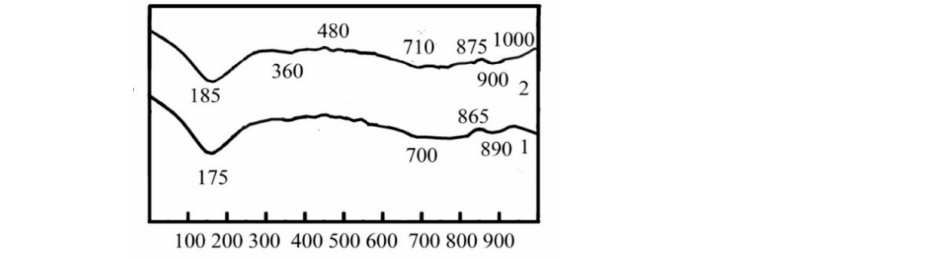
Figure 7. DTA results of the 180-day hydrated blast furnace cement mixed with sea water and